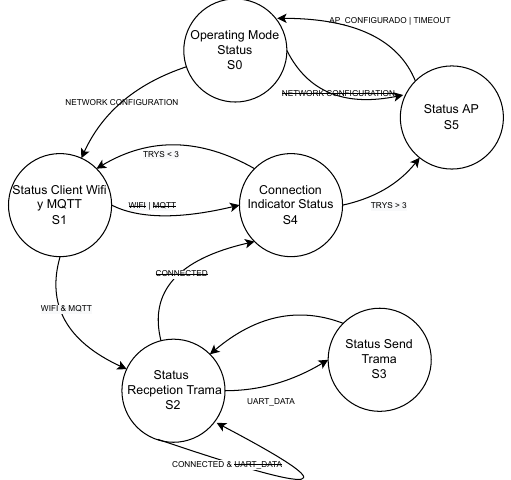
Figure 7. Scanning station FSM diagram for the BLE scanning phase (performed by the ESP32).